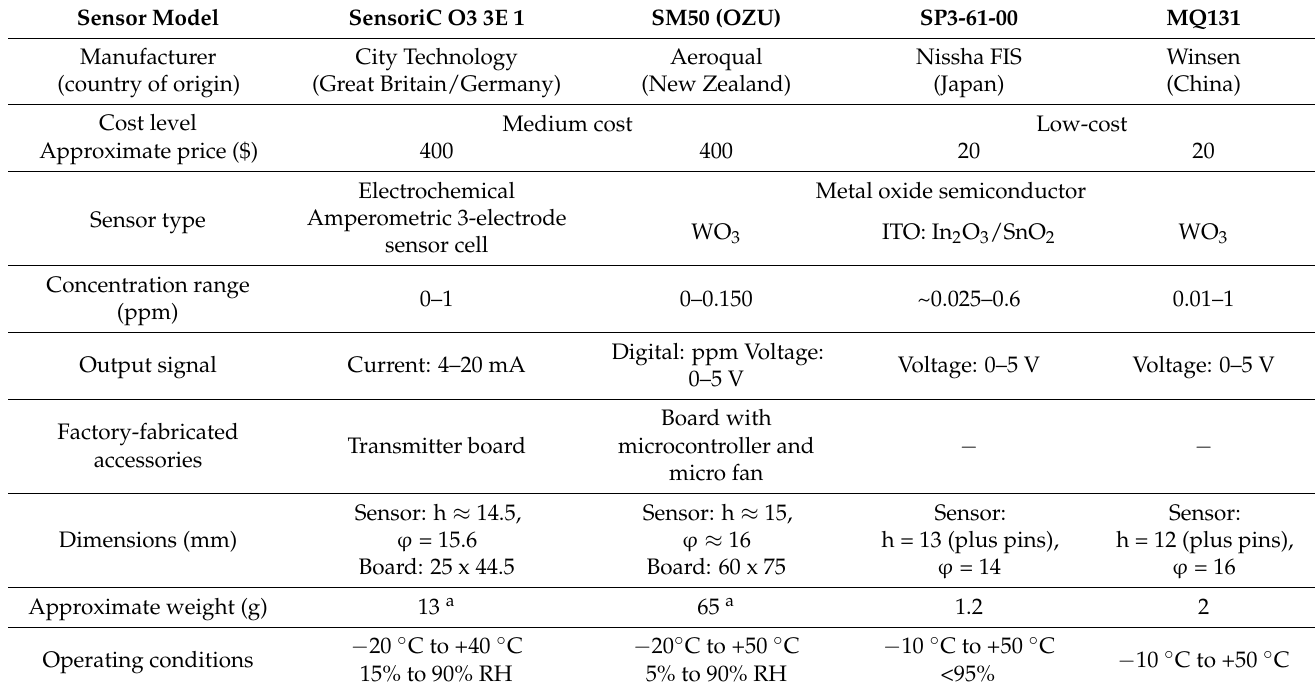
Table 1. Characteristics of the ozone sensors used in the